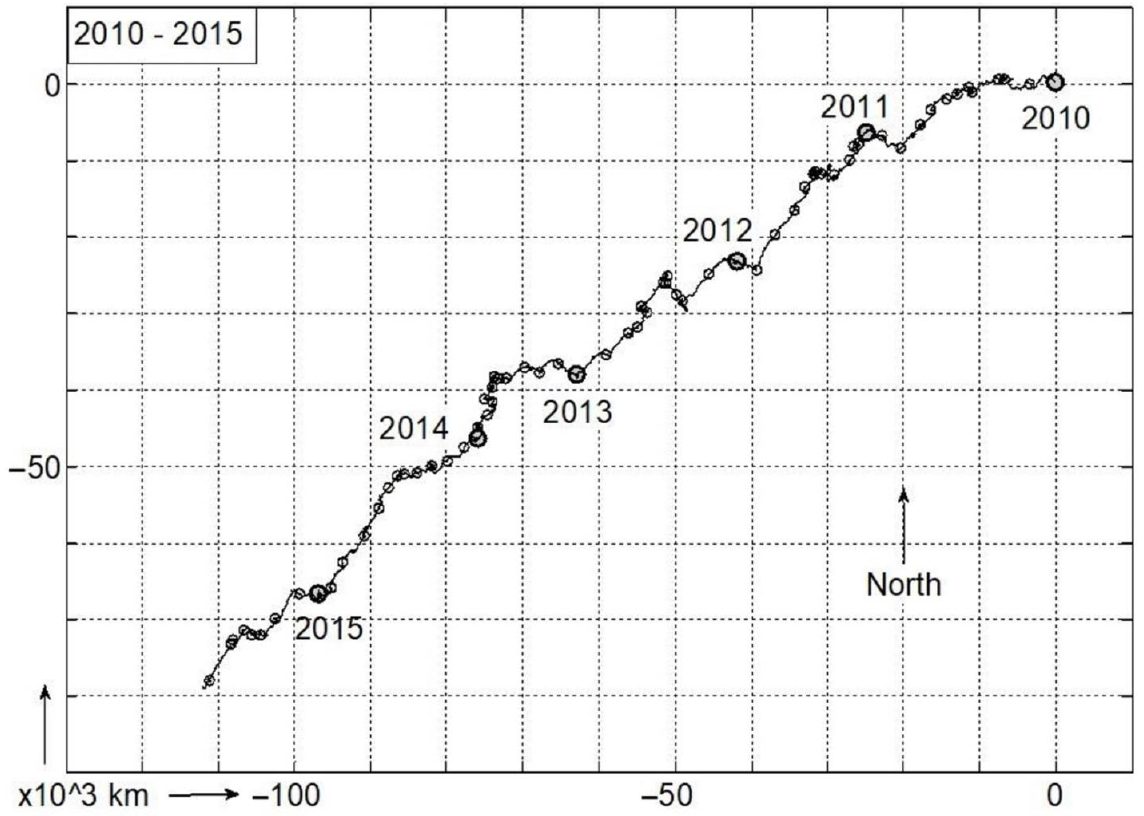
Figure 7. Progressive vector diagrams of the monthly averaged wind in the research area for the period 2010–2015. Vectors between dots show the prevailing wind direction.